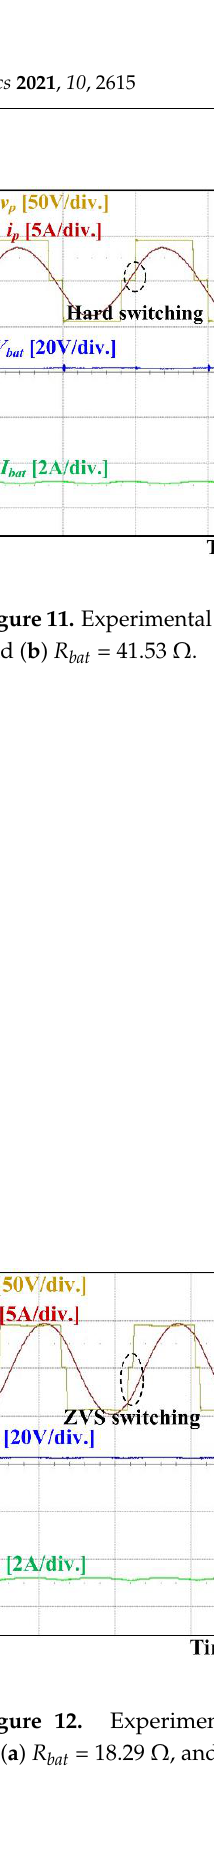
Figure 10. Experimental waveforms when the proposed WPT circuit operates in the CC mode with f s = f o at ( a ) R bat = 13.04 Ω, and ( b ) R bat = 17.04 Ω.